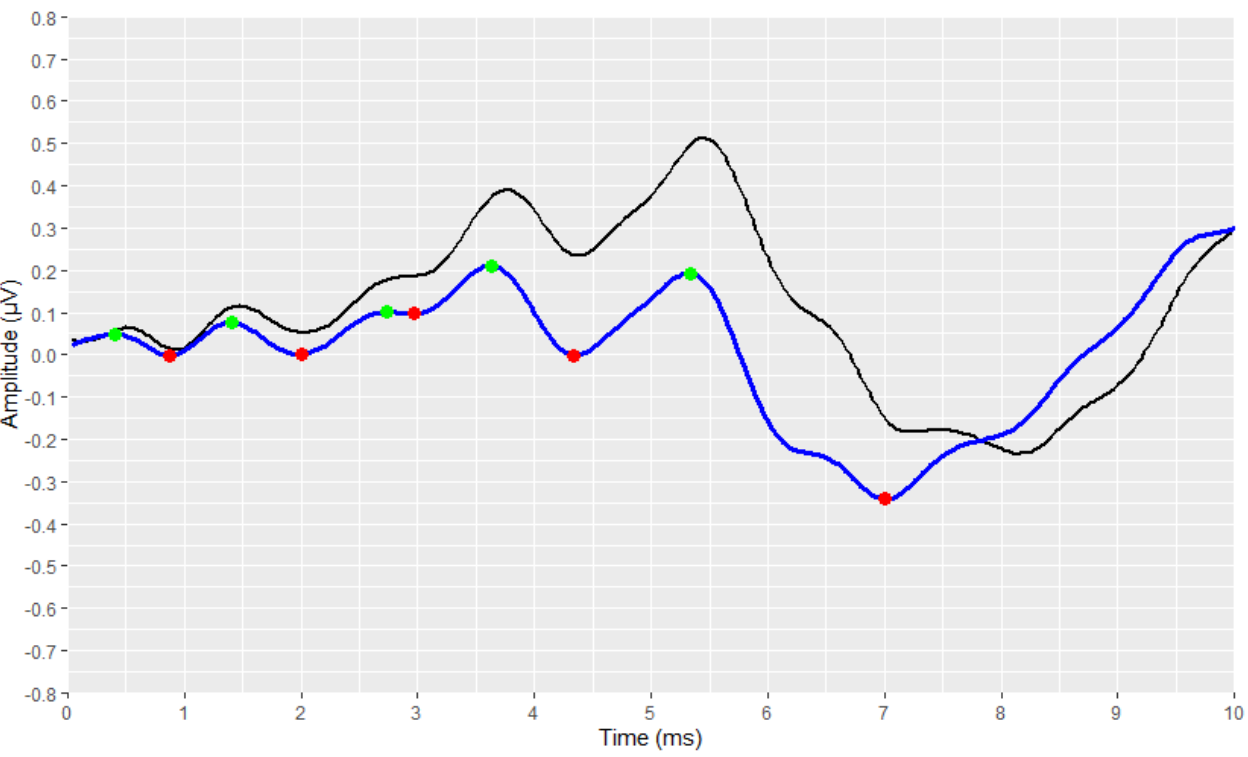
Figure 8. Detection of all local extremes (peaks in green, troughs in red) of the filtered ABR signal (raw signal is depicted in black and filtered signal is depicted in blue).